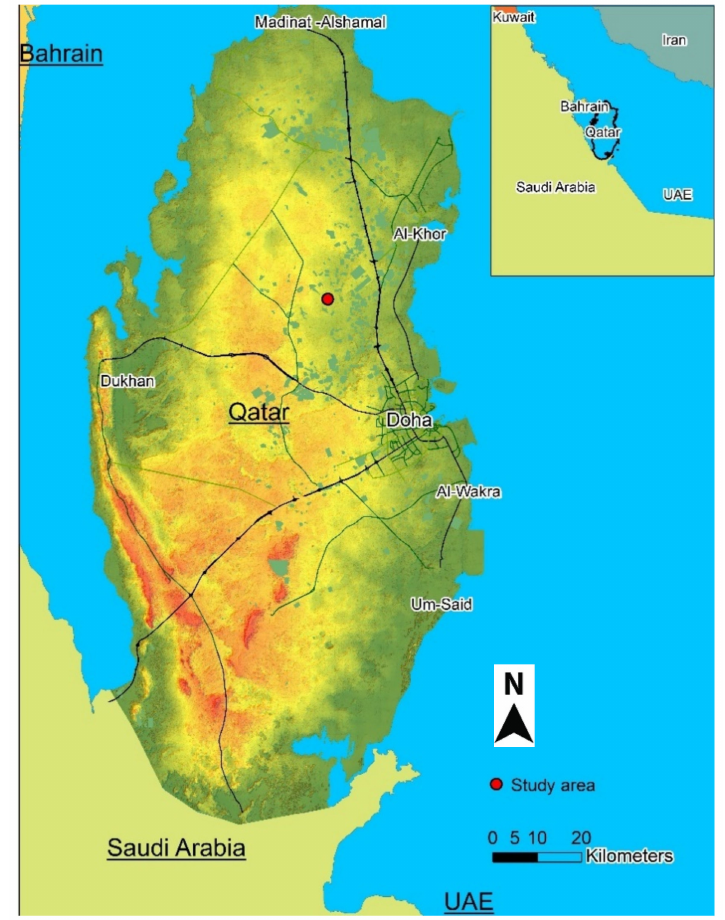
Figure 1. Qatar country map (regional map inset) and the study